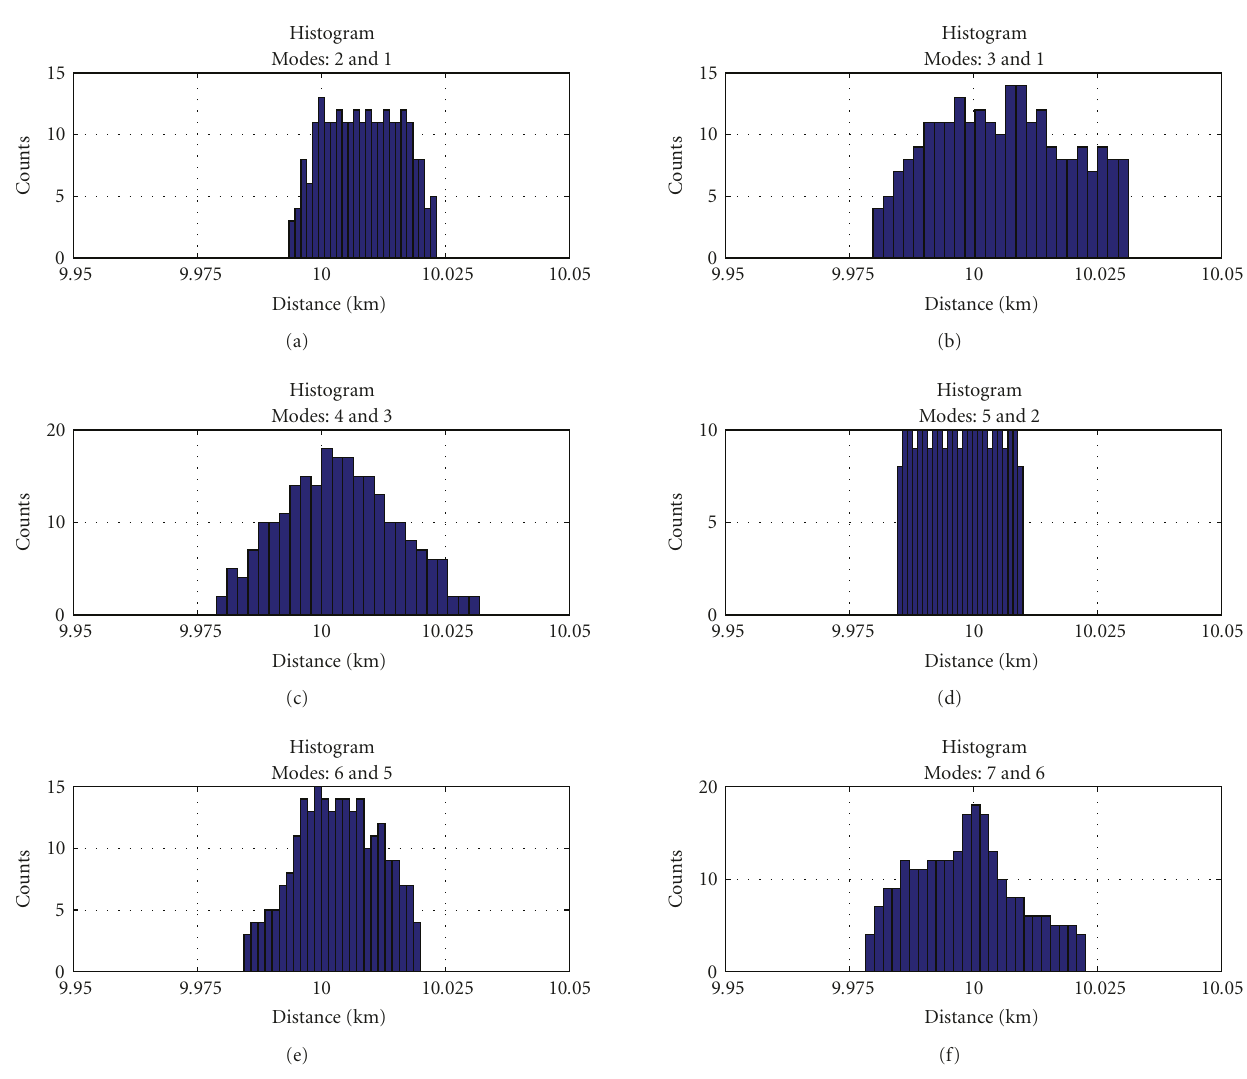
Figure 19: Results of distance estimation by F - K method for 6 mode couples. For each mode couple the estimation is done for all HLA hydrophones (240 distance estimations). The true value of distance is